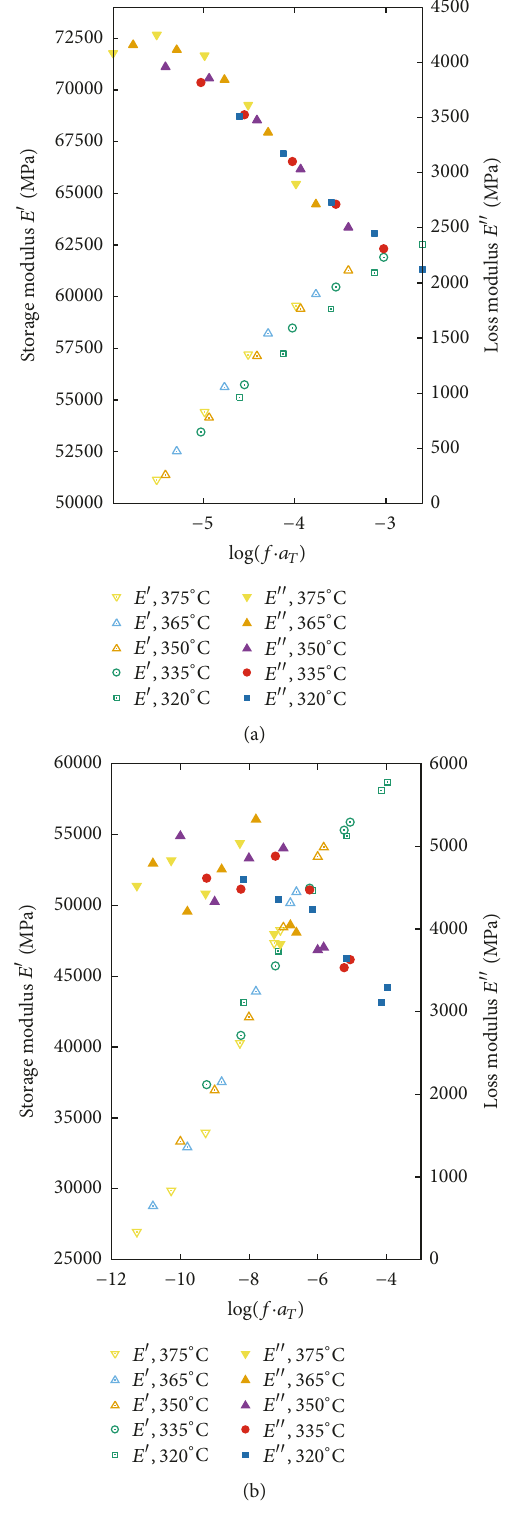
Figure 6: Master curves showing the storage modulus 𝐸 󸀠 (hollow symbols) and the loss modulus 𝐸 󸀠󸀠 (solid-fill symbols) versus the logarithm of the frequency 𝑓 times the shift factor 𝑎 𝑇 . These curves resulted from horizontal shifting of the isothermal curves of 𝐸 󸀠 and 𝐸 󸀠󸀠 fromDMAtestsonAA7075-T6(a)andsolutiontreatedAA7075 (b), from 320 to 375 ∘